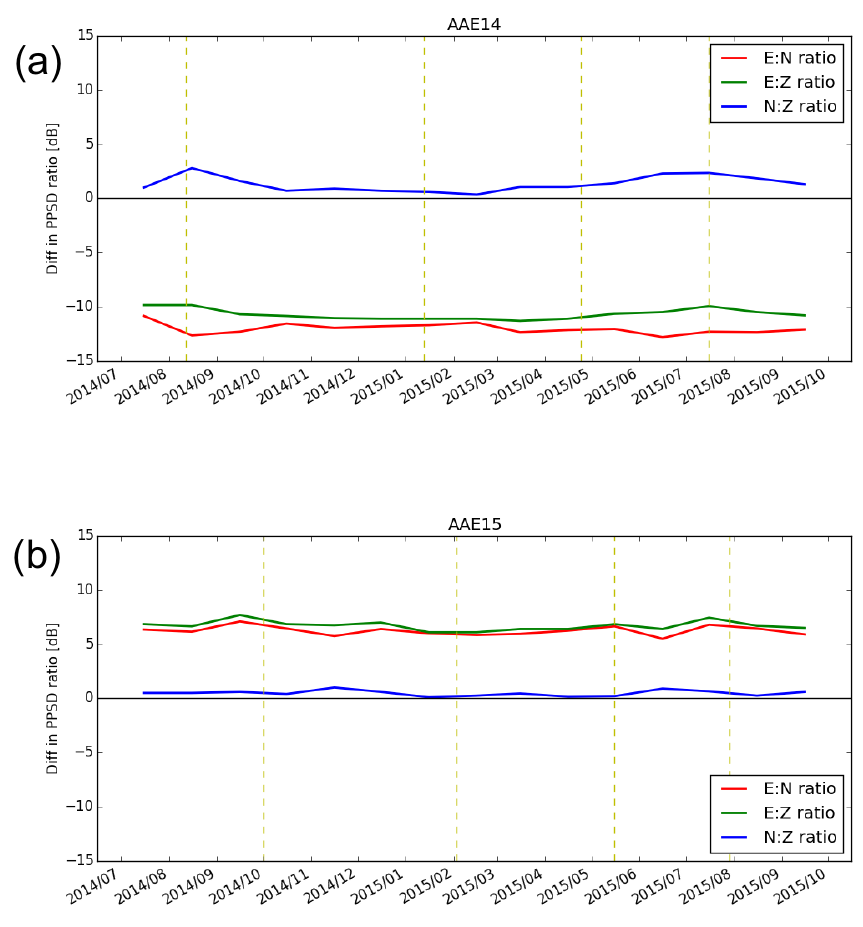
Figure 11. Seismometer gain check by the ambient noise gain method. Gain imperfection can be identified from monthly averages of normalized power spectral ratios. Both panels show that either gain of the EW component or gains of both the NS and Z components are not correct. To decide which amplitudes are correct and which are not, one has to check the gain of each component of the sensor–DAS pair with the calibration units, as described in Sect. 3.